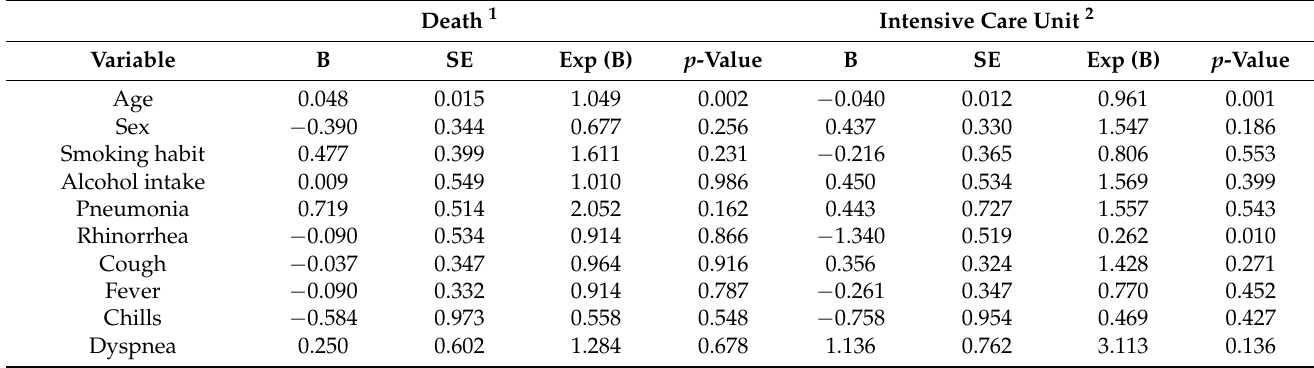
Table 3. Logistic regression analysis of the variables associated with COVID-19-related death, or admission into the Intensive Care